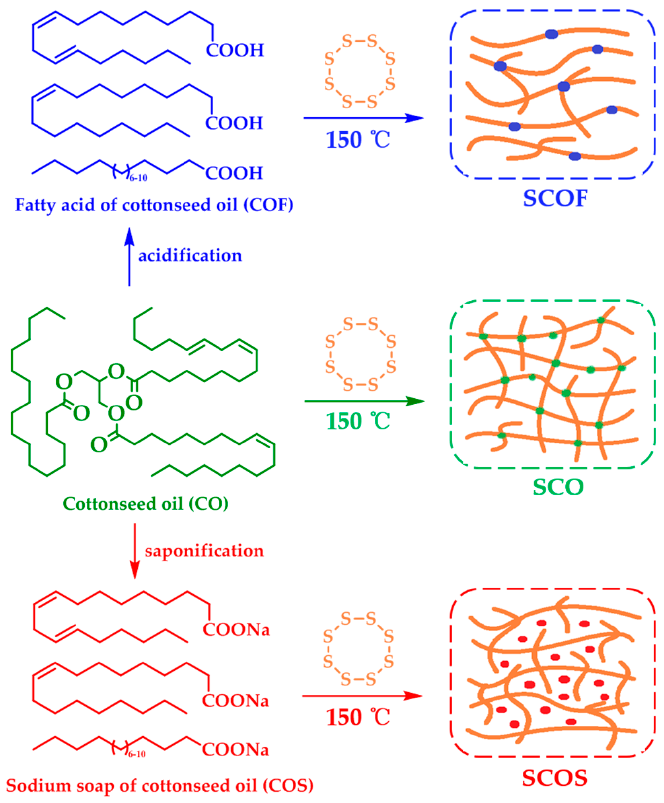
Figure 3. Procedures for the preparation of SCO, SCOF and SCOS, respectively.